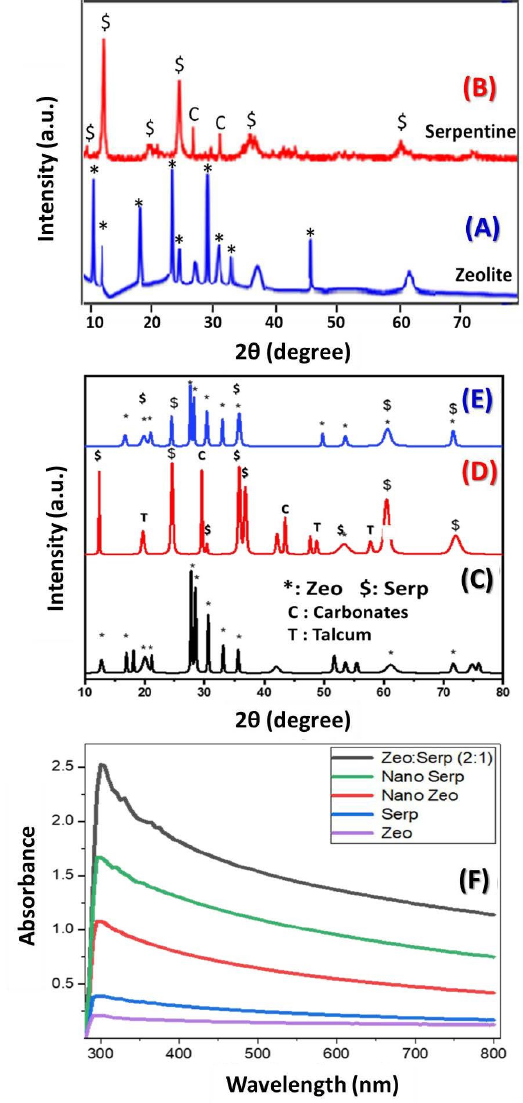
Figure 1. XRD patterns of zeolite ( A ) and serpentine ( B ) after ball milling; XRD patterns of zeolite ( C ), serpentine ( D ), and Zeo/Serp (2:1) composite ( E ) after hydrothermal; and ( F ) optical absorbance spectra of the different samples.